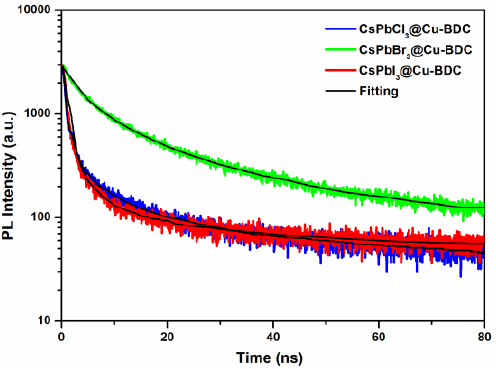
Figure 7. The photoluminescence (PL) emission decay curves of CsPbCl 3 @Cu-BDC, CsPbBr 3 @Cu-BDC, CsPbI 3 @Cu-BDC.